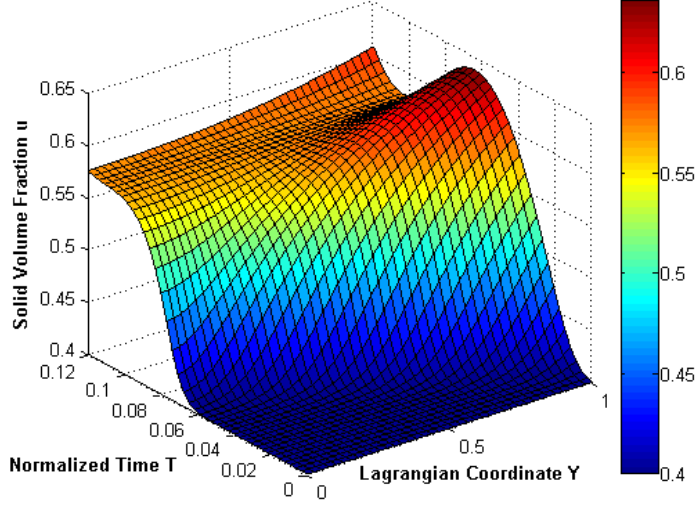
Figure 5. Solid volume fraction as a function of Lagrangian coordinate Y and normalized time T for piston velocity v ( T ) = 3 [ 1 − cos ( 20 π T )]